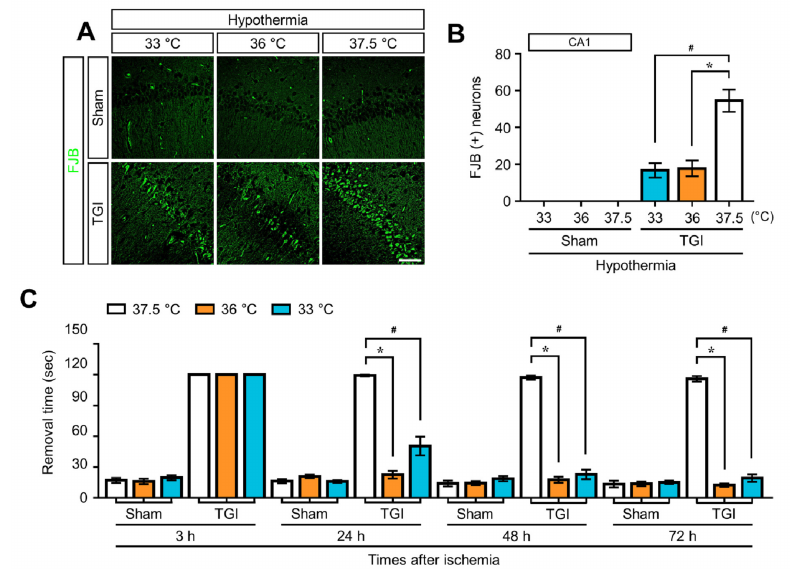
Figure 1. Target temperature management (TTM) suppresses transient global ischemia (TGI)-induced neuronal death and sensorimotor deficit. ( A ) Brain sections were stained with Fluoro-Jade B fluo- rescent dye to detect degenerating neurons. TGI at a normal temperature of 37.5 ◦ C significantly increased the number of fluorescent cells in the hippocampal cornus ammonis 1 region. These cells were significantly decreased after TGI-TTM at 33 ◦ C and 36 ◦ C. There were no differences between the sham groups. Scale bar = 50 µ m. ( B ) Bar graph represents the total number of Fluoro-Jade B-positive cells (one way-ANOVA, multiple comparison following Bonferroni adjustment. Sham + 33 ◦ C, n = 5; Sham + 36 ◦ C, n = 5; Sham + 37.5 ◦ C, n = 5; TGI + 33 ◦ C, n = 8; TGI + 36 ◦ C, n = 5; TGI + 37.5, n = 8. * p and # p < 0.05). ( C ) Adhesive removal test to observe sensorimotor deficit proceeded 3 to 72 h after TGI (tested daily). There were no differences in the removal time in each sham group assessment. TGI-TTM at 33 ◦ C and 36 ◦ C significantly reduced the removal time (time-dependent) compared to TGI at normal temperature at 37.5 ◦ C (one way-ANOVA, multiple comparison following Bonferroni adjustment. Sham + 33 ◦ C, n = 5; Sham + 36 ◦ C, n = 5; Sham + 37.5 ◦ C, n = 5; TGI + 33 ◦ C, n = 9; TGI + 36 ◦ C, n = 7; TGI + 37.5, n = 8. * p and # p <